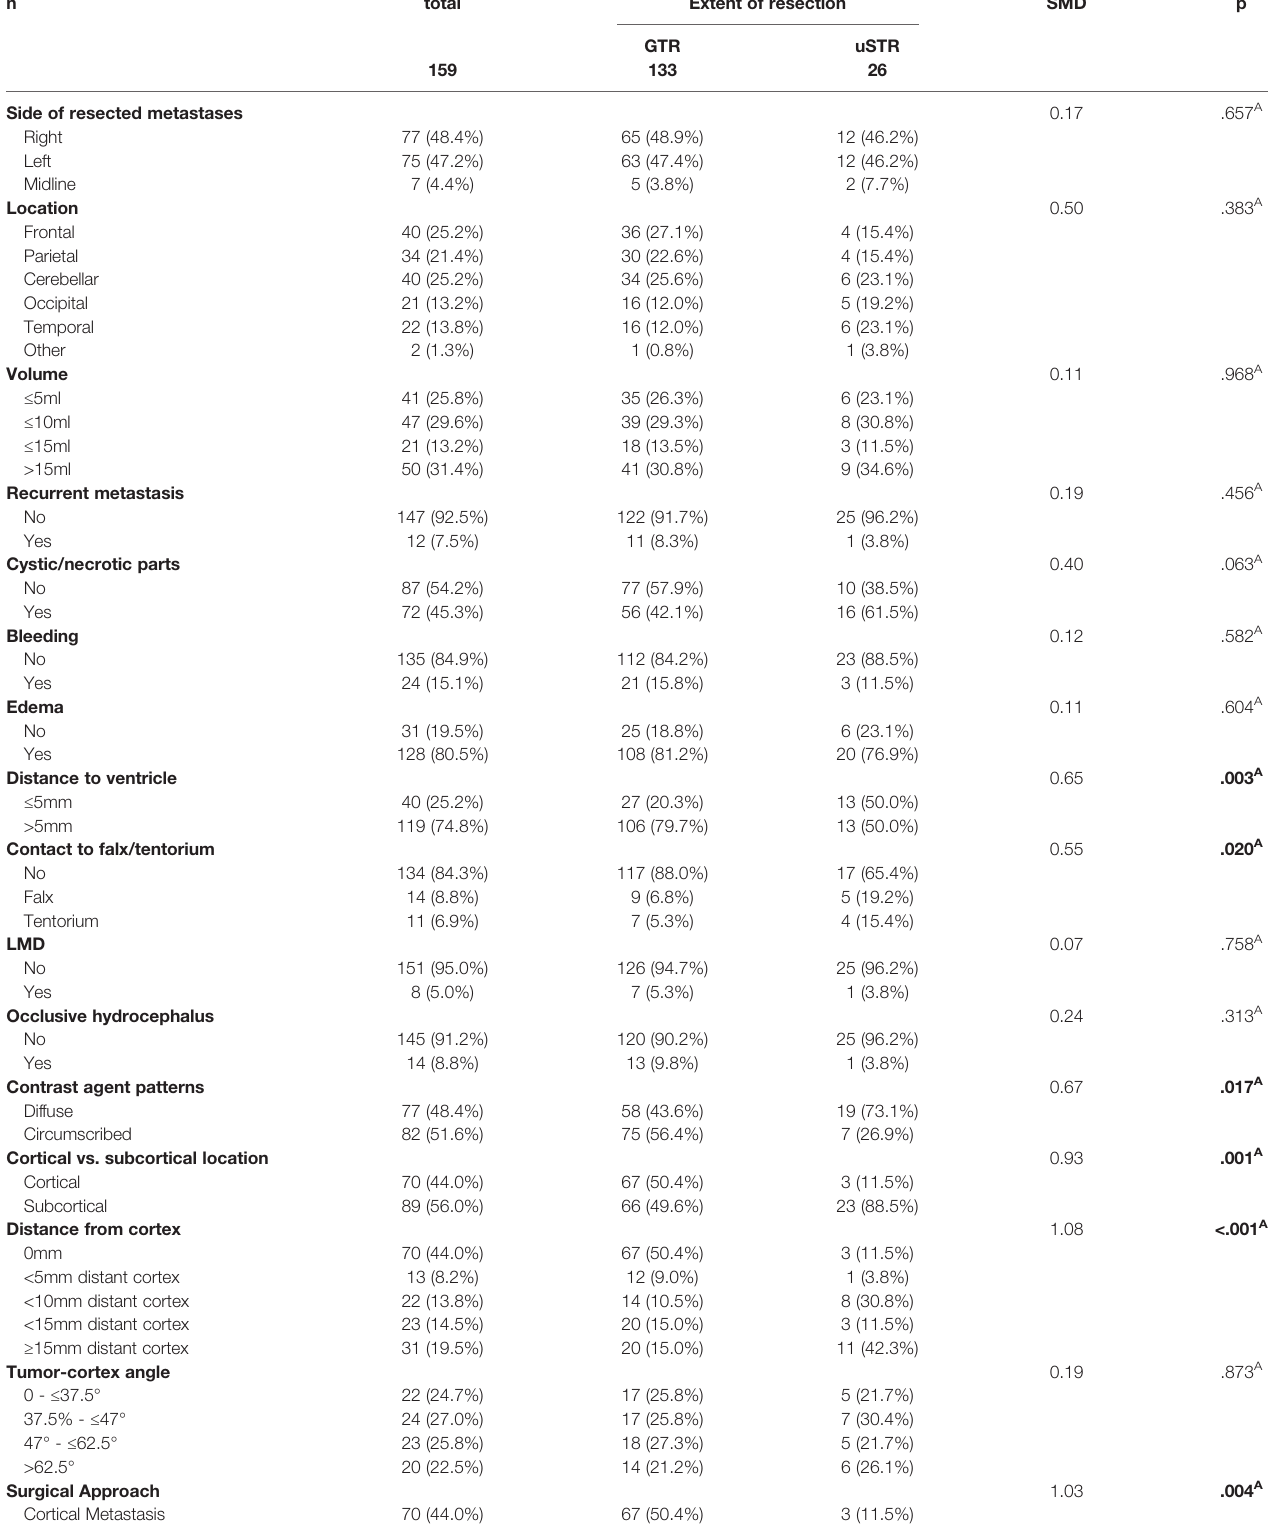
TABLE 2 | Bivariate Analysis for Unintended Subtotal